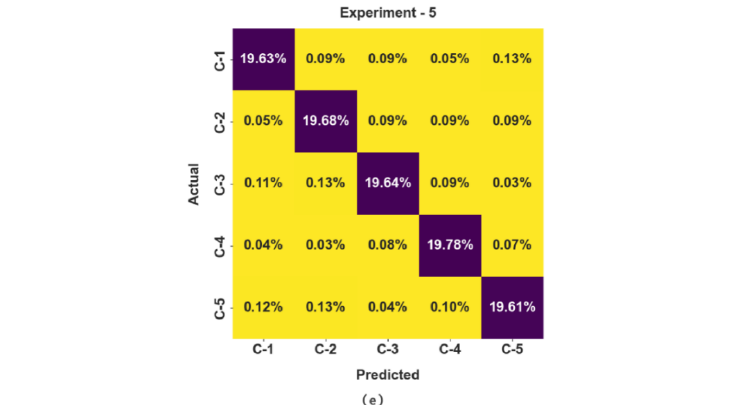
Figure 3. Confusion matrices of AOEDBC-DL system ( a ) Experiment-1, ( b ) Experiment-2, ( c ) Experiment-3, ( d ) Experiment-4, and ( e ) Experiment-5.